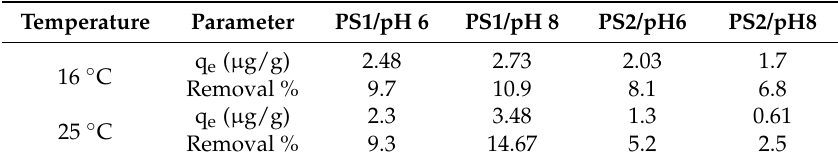
Figure 4. Adsorption kinetics of CBZ at ( a ) 16 °C and ( b ) 25 °C onto two particle sizes of tezontle (PS1, PS2) at pH 6 and pH 8. Table 2. Equilibrium adsorption capacity (q e ) and its equivalent removal percentage at the different levels of particle size, pH and temperature.